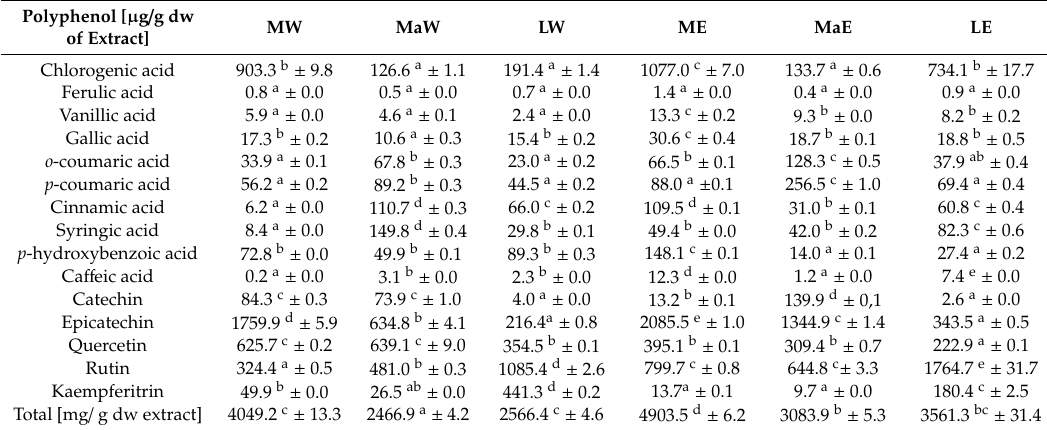
Table 2. Polyphenols content in Humulus lupulus L. hops extracts.